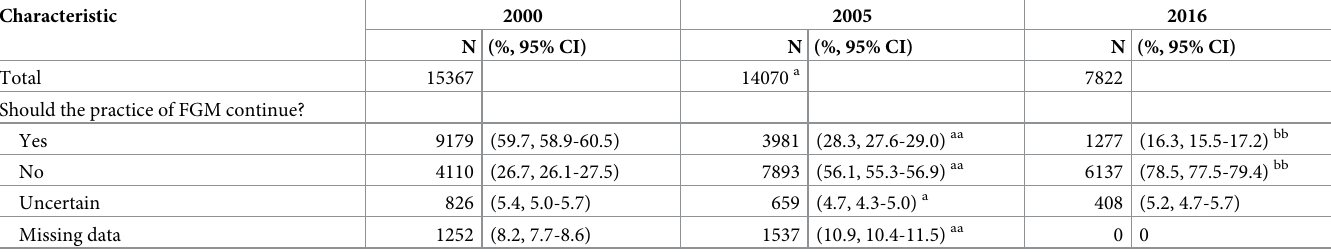
Table 1. Opinions about whether the practice of female genital mutilation (FGM) in Ethiopia should continue: 2000, 2005 and 2016. Characteristic